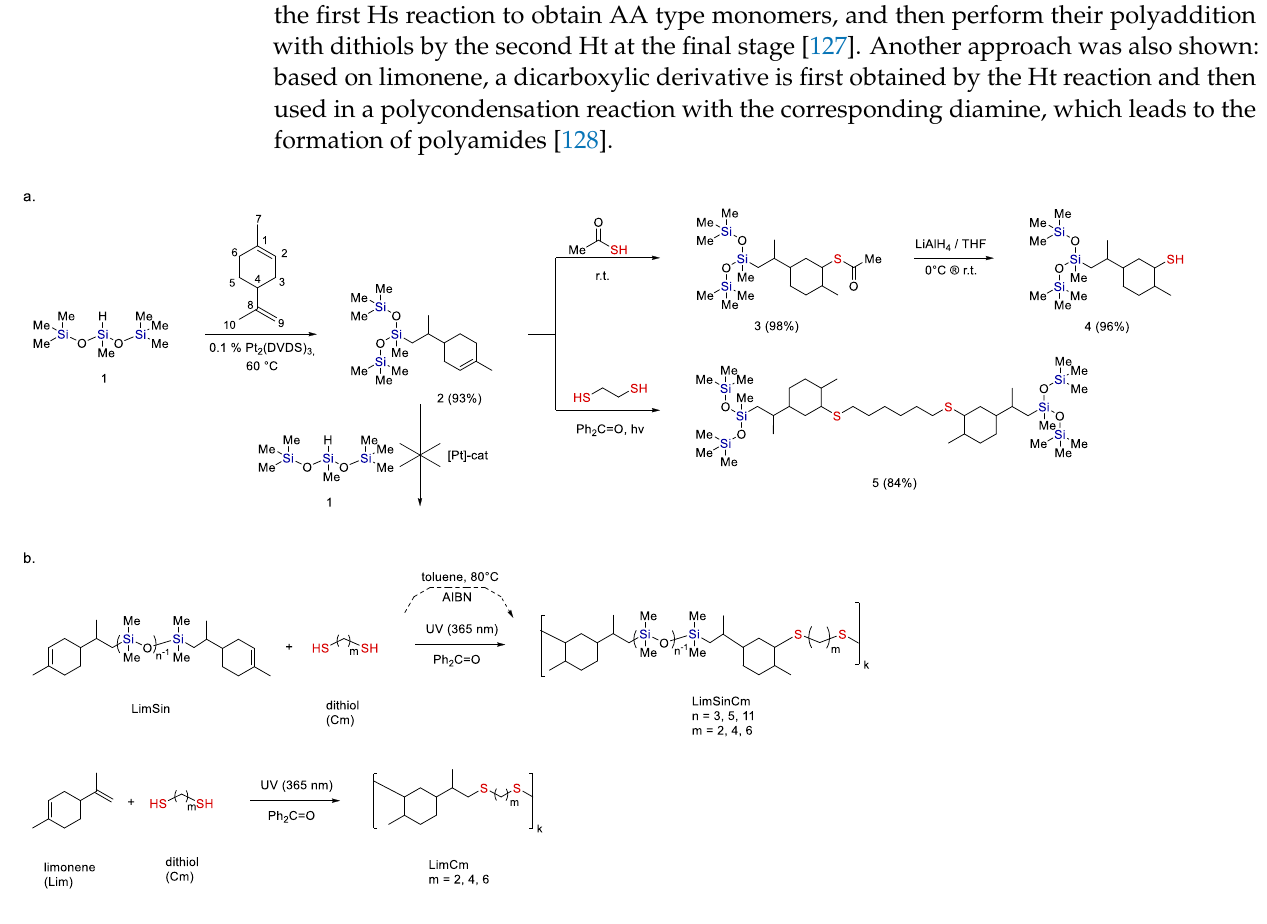
Figure 29. Strategies for the synthesis of functional limonene derivatives by hydrosilylation and hydrothiolation ( a ) [127]; synthesis of limonene-based copolymers by thiol-ene polyaddition ( b ) [128]. Adopted from Refs.